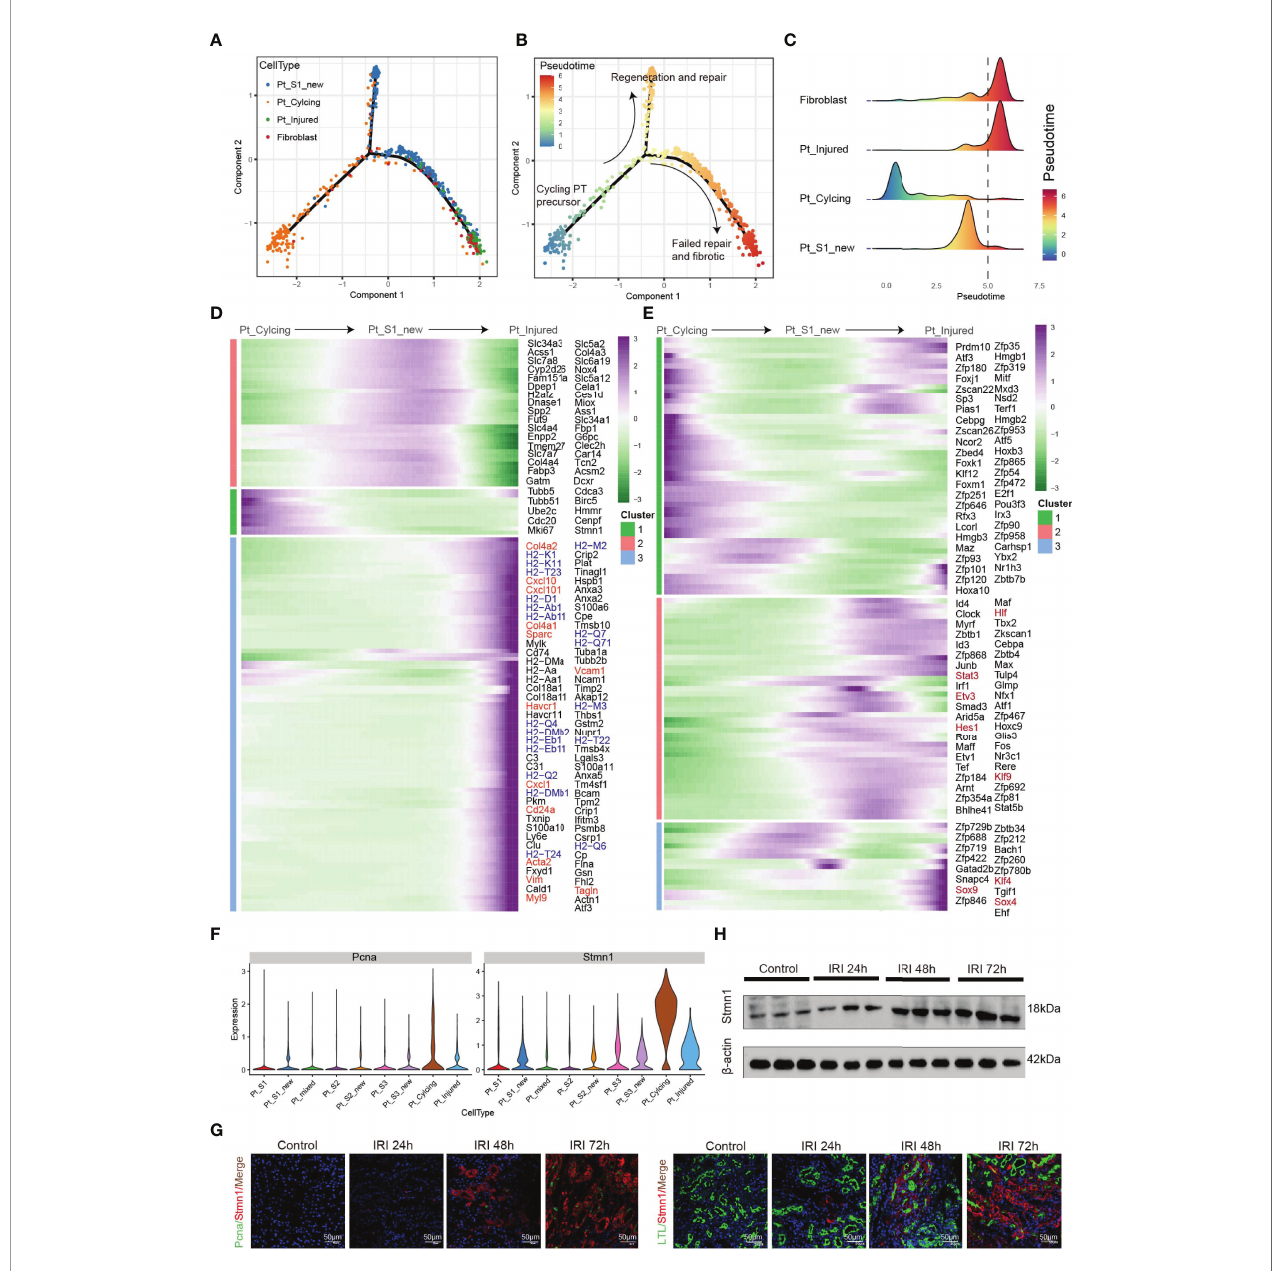
FIGURE 4 | Pseudo-time trajectory analysis among PTC. (A – C) Potential differentiation routines among PTC-S1-new, PTC-cycling, PTC-injured, and fi broblast. (D, E) Pseudo-temporal expression dynamics of speci fi c representative genes (D) and transcriptome factors (E) alongside AKI progression. (F) The expression of cycling marker Stmn1 and Pcna in PTC subtypes. (G) Immunostaining showing the distribution of cycling PTC alongside the AKI progression. (H) Western blot showed the expression of Stmn1 with the time-dependent effect of IRI in the mouse